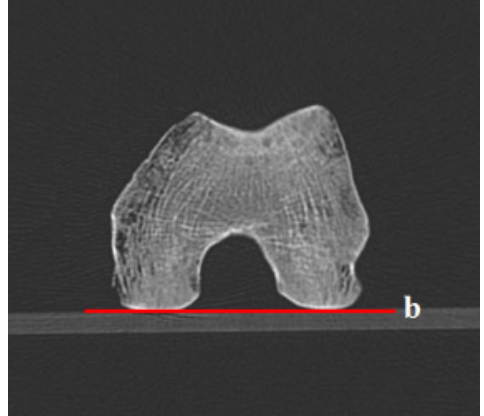
Figure 4. The distal reference line on the transverse section measures the femoral anteversion using 2D computed tomography (CT) scans. The b red line represents the connecting line of both femoral condyles’ most prominent posterior border.